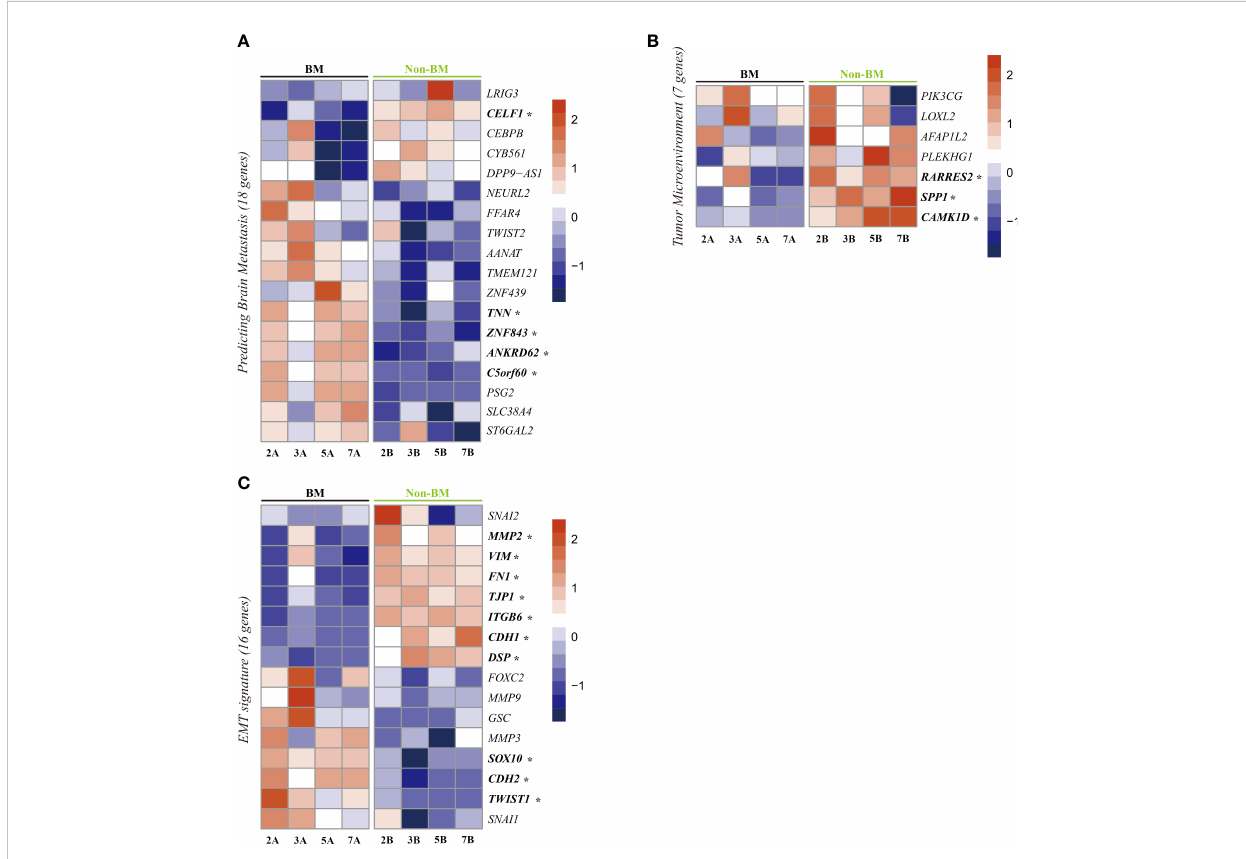
FIGURE 5 Heatmap visualization of gene expression related to brain metastasis. (A) , tumor microenvironment (B) , and epithelial-mesenchymal transition (C) in lung cancer with brain metastasis and lung cancer without brain metastasis. *Signi fi cant DEGs (p-value